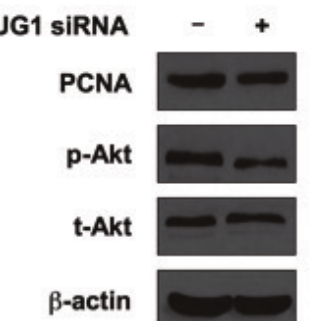
need to be carried out to verify its pro-tumor activity and